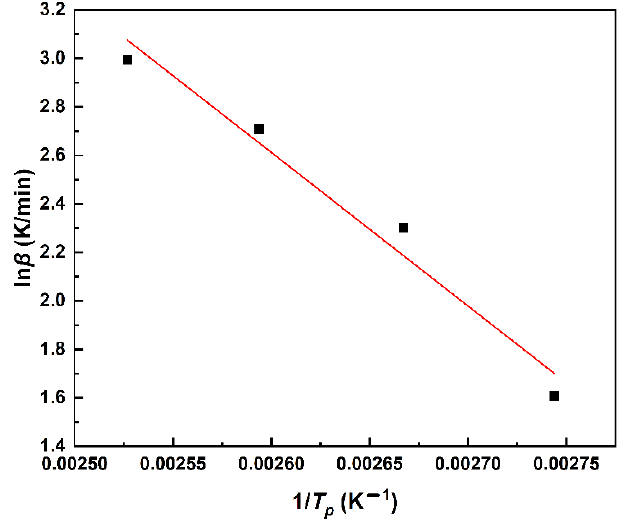
Figure 7. The linear fit of ln β and1/ T p by Crane equation.